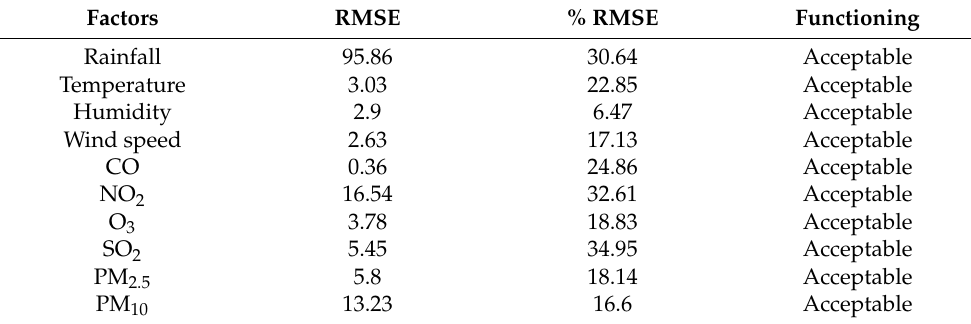
Table 1. Result of interpolation